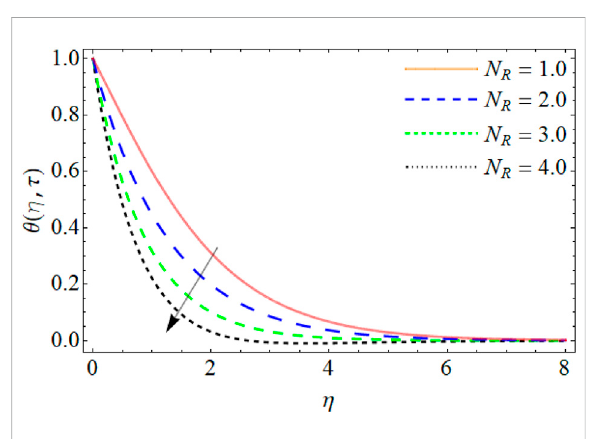
FIGURE 7 Velocity outlines g ( η , τ ) versus Grashof number Gr .